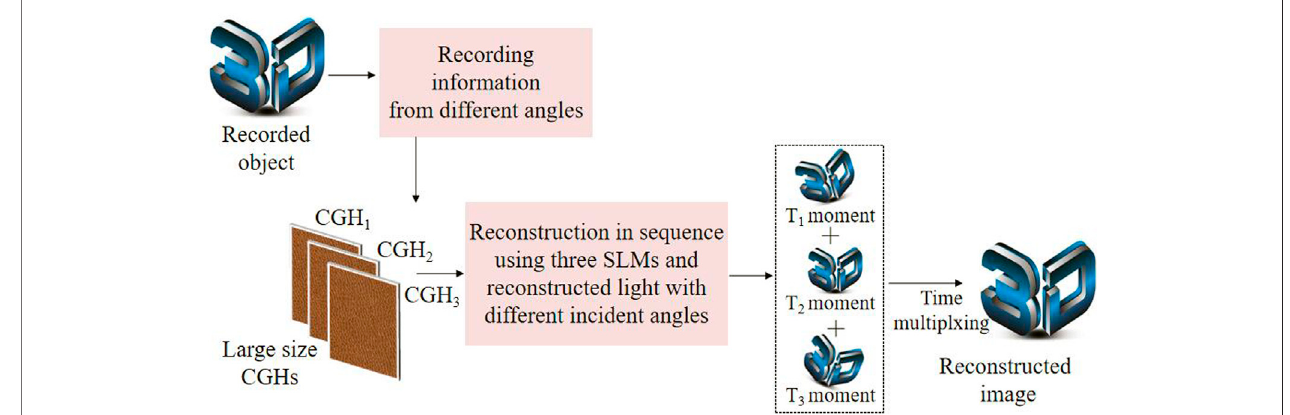
FIGURE 1 | Schematic diagram of the proposed method.